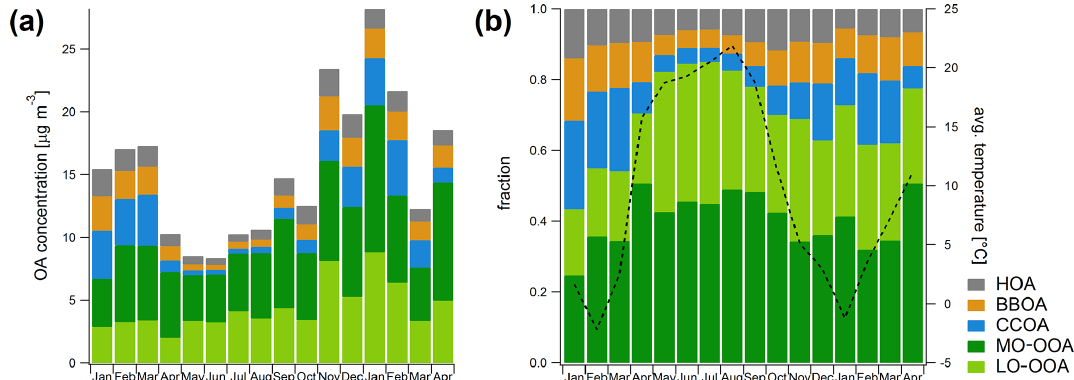
Figure 4. (a) Monthly concentrations and (b) contributions of the different sources to the total OA mass. While HOA has a similar con- tribution throughout the campaign, the solid-fuel-combustion-related BBOA and CCOA show a clear seasonal pattern with the highest contributions during winter. The contributions of MO-OOA and LO-OOA are highest during summer.